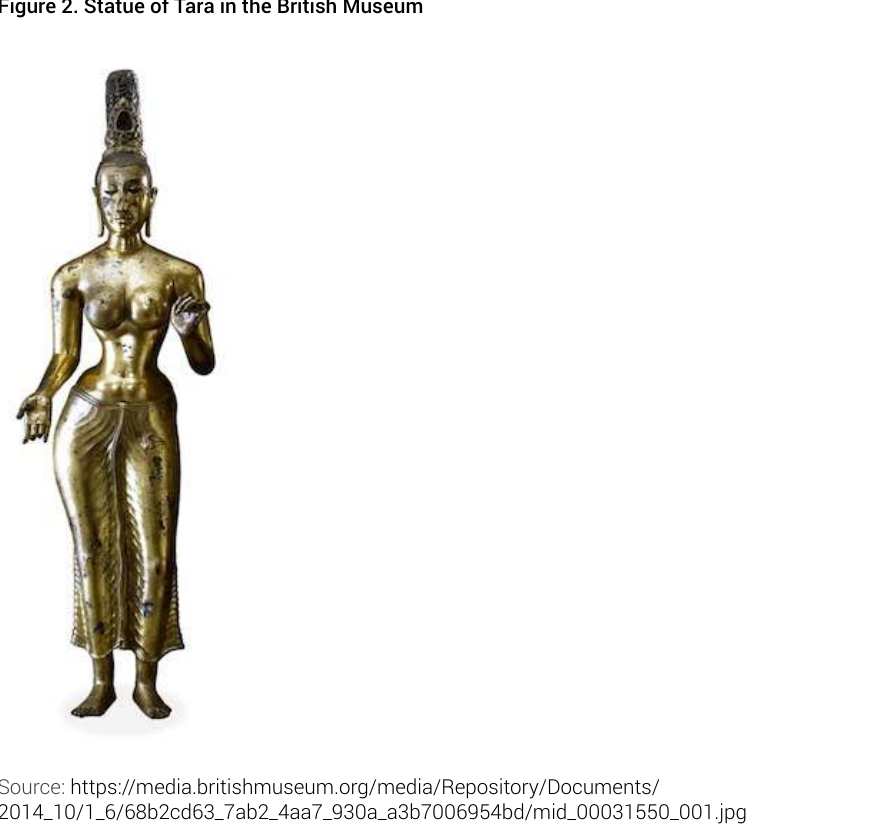
Figure 2. Statue of Tara in the British